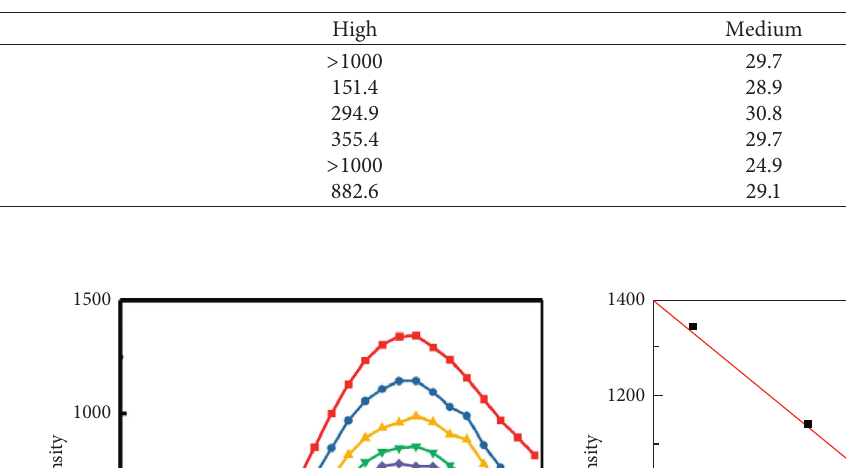
Figure 5: Array-based sensing of human serum samples with different CA125 levels. (a) Fluorescence emission intensity (610nm) patterns of the 3 types of samples (low, medium, and high level of CA125) on the AuNCs array as an average of six patient samples. (b) LDA shows the excellent separation of the samples with different levels of CA125. Table 2: Determination of CA125 by the traditional chemiluminescence method.